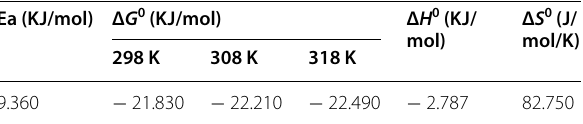
Table 4 Activation energy and thermodynamic parameters for adsorption of chromium